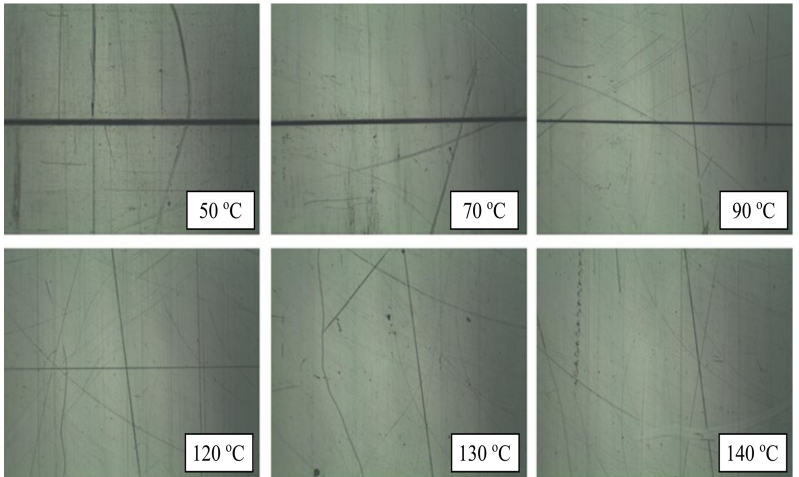
Figure 12. Micrograph of the weld marks or weld lines on the surface of the molded specimen under different cavity surface temperatures just before filling [47]. Nian et al. [45] studied the key parameters and optimized design of single-layer in- duction coils for external rapid mold surface heating by controlling the process parame- ters of induction heating (suitable for applications involving mold plates with different thicknesses and coil positions). Figure 13 depicts the spatial dimensions used in the sim- ulation. An experiment was performed to validate the thickness of the heated workpiece (SKD61) and the induction coil (copper) position influencing the heating rate and temper- ature uniformity. Furthermore, the Taguchi method and principal component analysis were used to identify the best control factor combination to obtain high heating rates with low temperature deviations. According to the simulation results, the position of the in- duction coil and the thickness of the workpiece were indeed important design parameters. The optimal parameters indicated heating a 10 mm thick workpiece when designing a single-layer induction coil with a 15 mm turn pitch at a distance of 5 mm from the heating target. Additionally, the coil position should not be offset, and the operating frequency and waiting time must be set to 35 kHz and 6 s, correspondingly. Furthermore, the results of the experiments showed that an optimized design of the induction coil outperformed conventional single-layer coils in terms of temperature uniformity. The heating rate in- creased from 3.3 °C/s to 4 °C/s (an increase of 19.5%), and the heating uniformity increased by 62.9%. In terms of model validity, all MAPE values indicated high prediction accuracy. However, other important tests such as strength tests, as well as an observation of the appearance of the molded part produced by the induction heated mold surface were not performed.